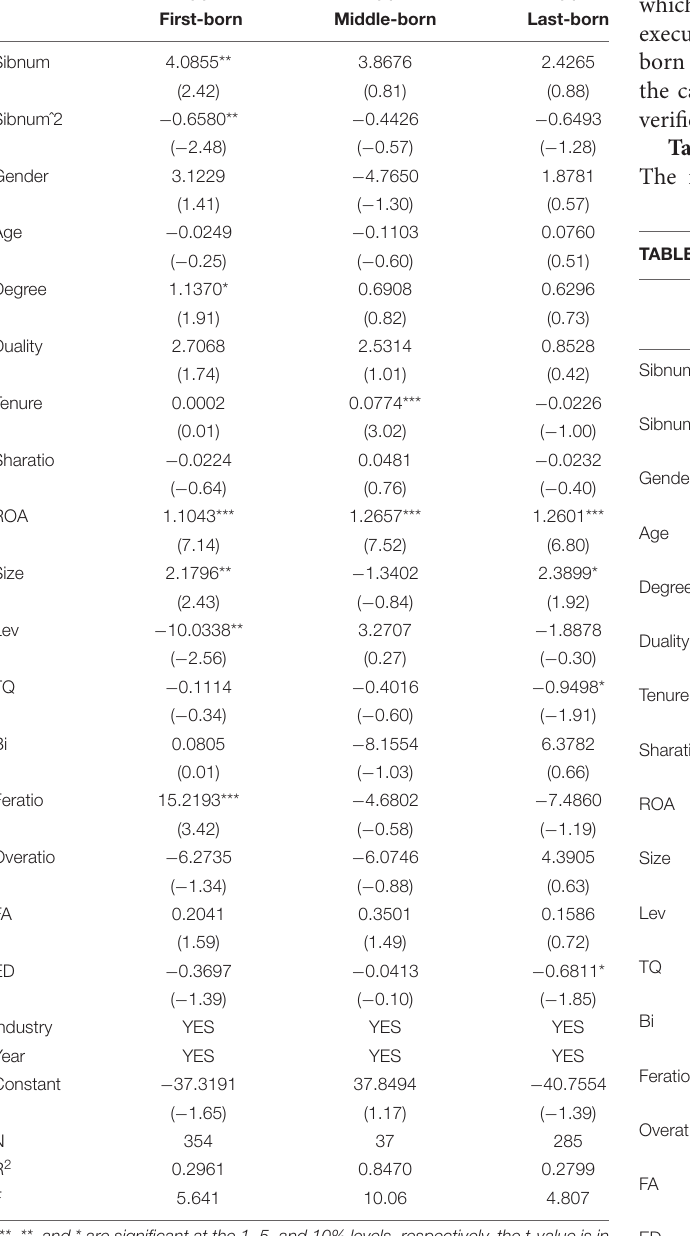
TABLE 5 | Moderating effect of CEO birth